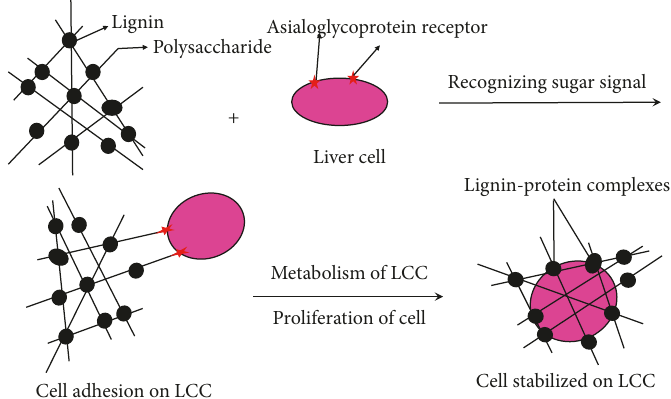
Figure 2: Binding of LCC material to